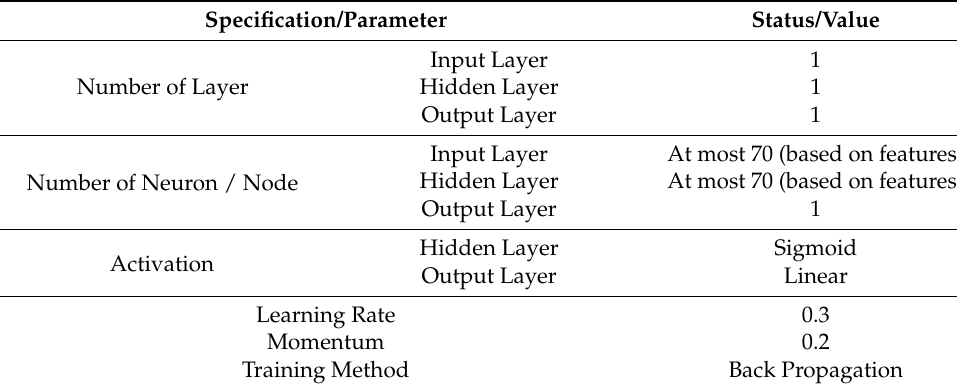
Table 2. Specifications and parameters of artificial neural network (ANN).